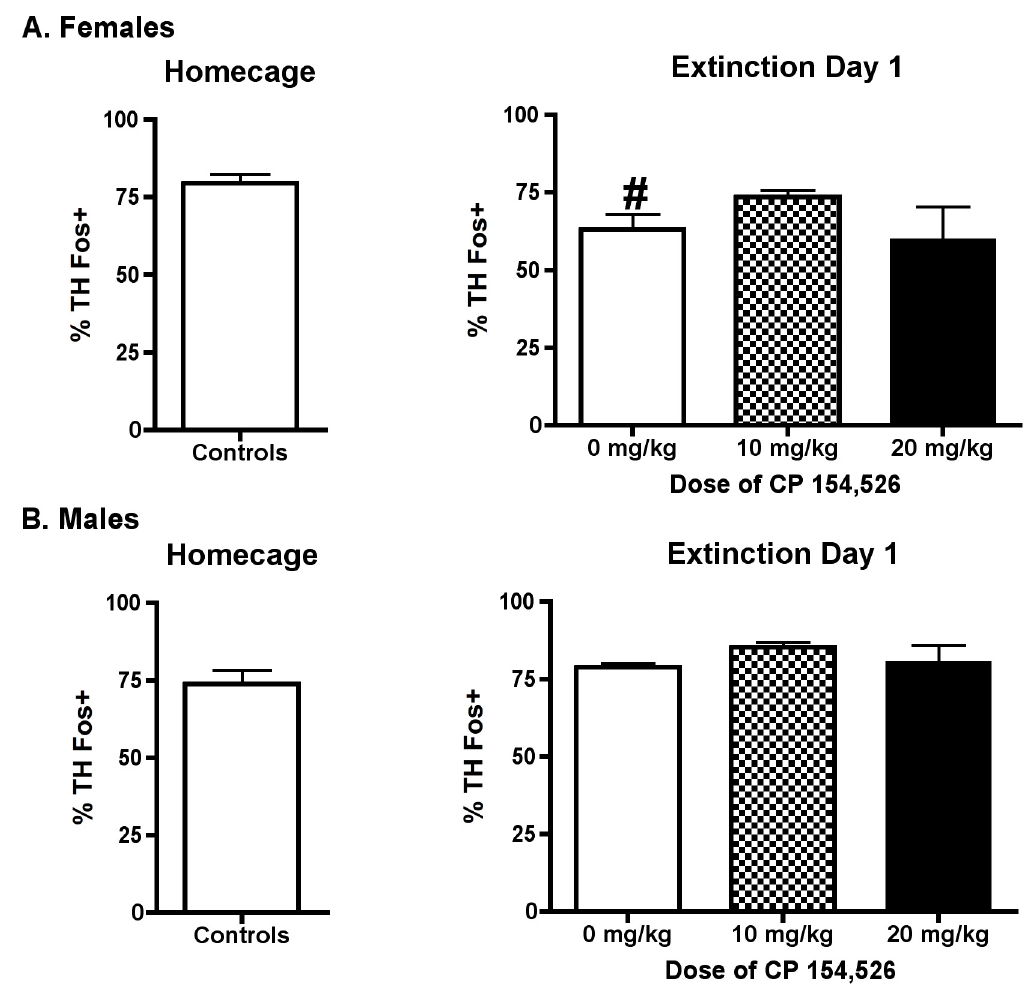
Fig 4. % TH neurons Fos+ in A1. The % of TH neurons Fos positive was decreased compared to home cage controls on ED1 in female rats, but not male, rats. CP had no effect on the percentage of TH neurons Fos positive on ED1 In female or male rats. # p < 0.05 versus home